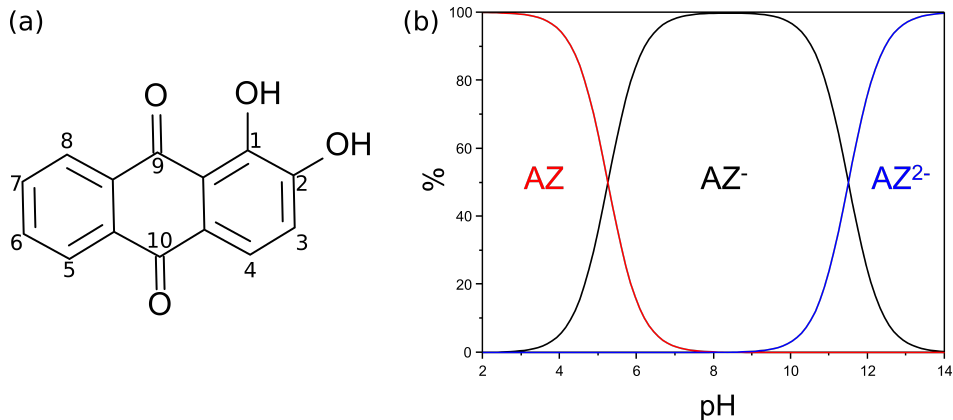
Figure 1. ( a ) Alizarin skeletal with atom labels. ( b ) Distribution diagram for alizarin species as a function of pH, for the AZ/AZ − /AZ 2 − system. The two pK of AZ are 5.25 and 11.5,